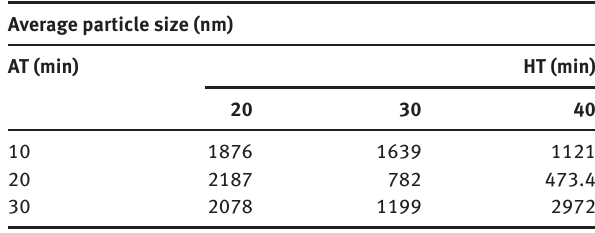
Table 3: Average particle sizes with respect to different HTs and ATs. Average particle size (nm)